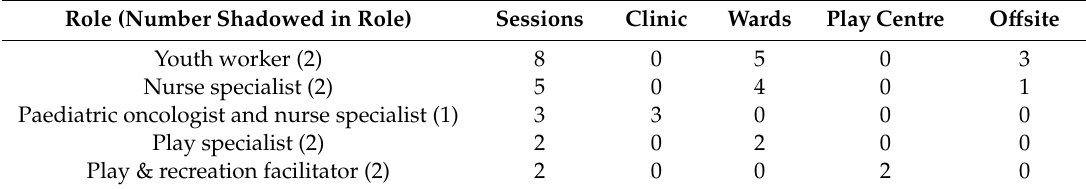
Table 3. Number of shadowing sessions and roles